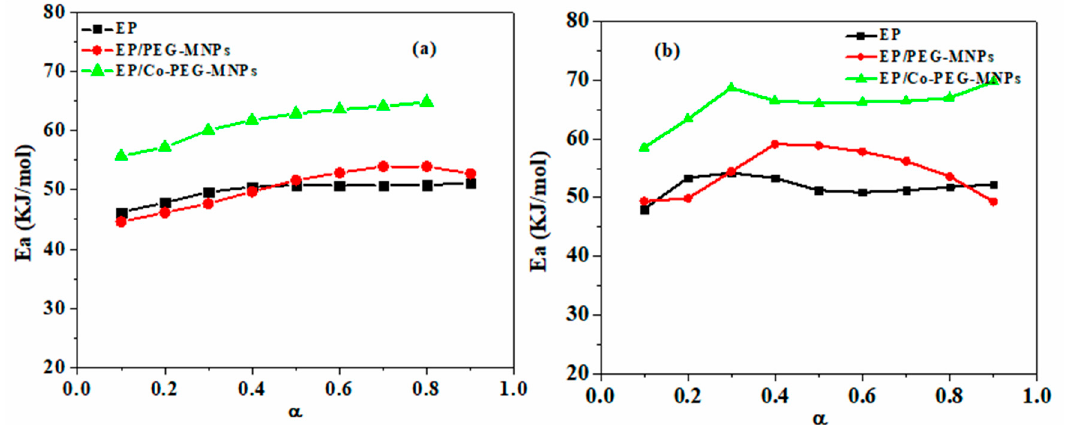
Figure 10. The variation of E α for EP, EP/PEG-MNPs and EP/Co-PEG-MNPs nanocomposites according to: ( a ) the Friedman model; and ( b ) the KAS model.